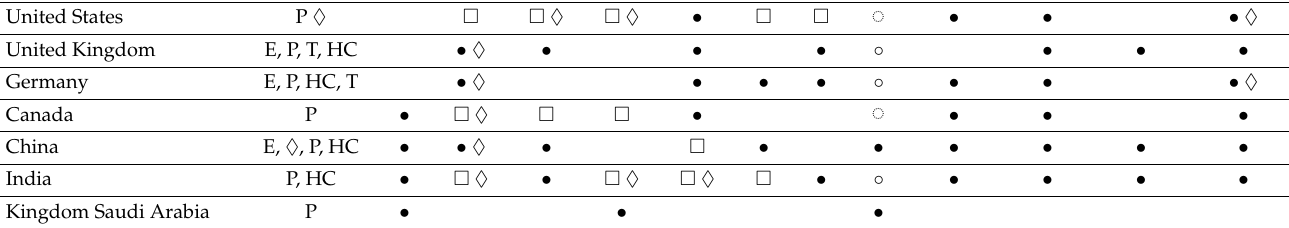
Table 1. RE policies in different countries including KSA—comparative